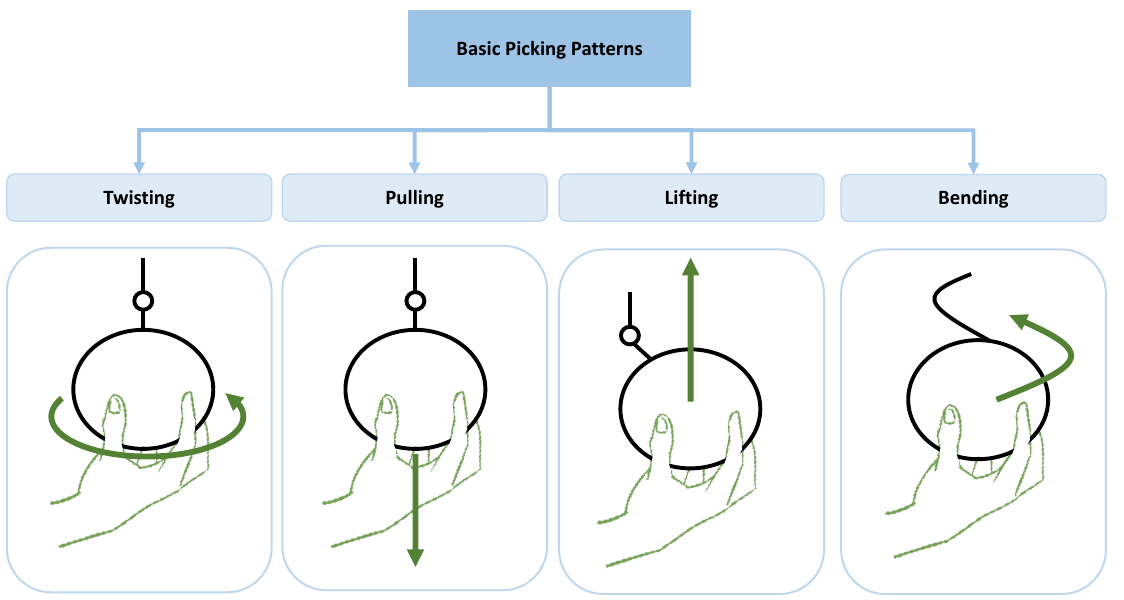
Figure 2. Simplified scheme of basic picking